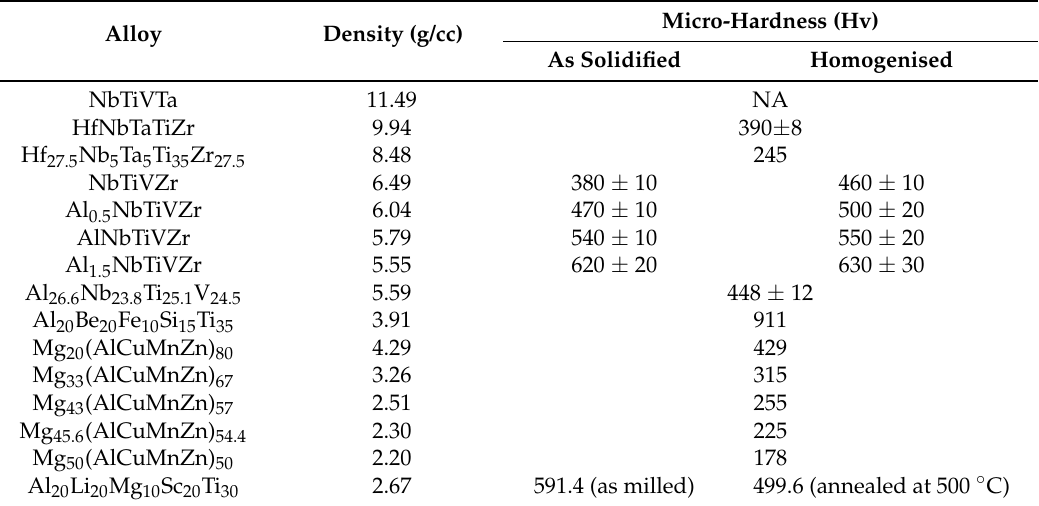
Table 3. Trend of microhardness in different